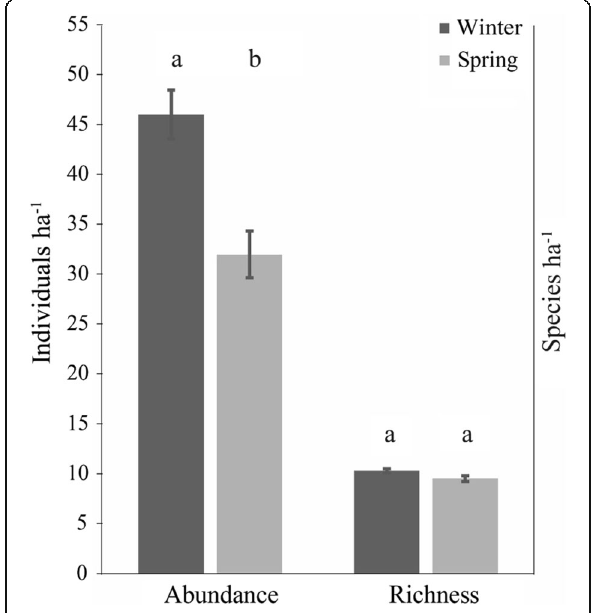
Fig. 2 Comparison of abundance of individuals and species richness (± SE) between seasons ( N = 111 plots). Different letters represent significant differences between seasons